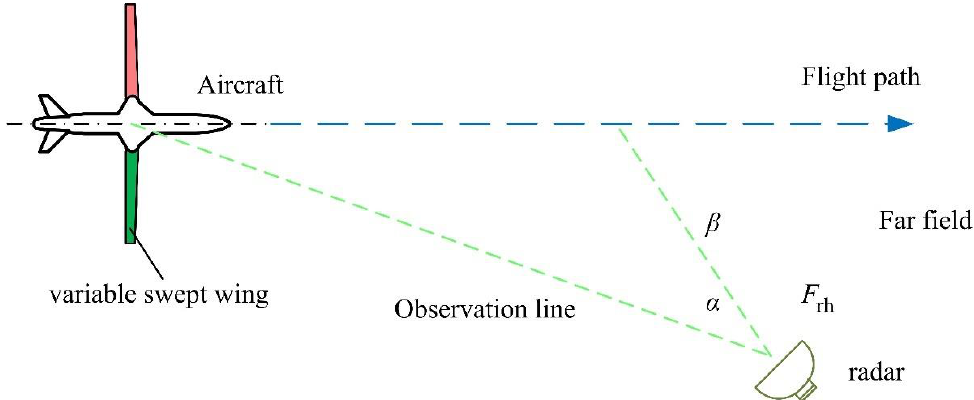
Figure 1. Schematic diagram of radar detection threat in phase